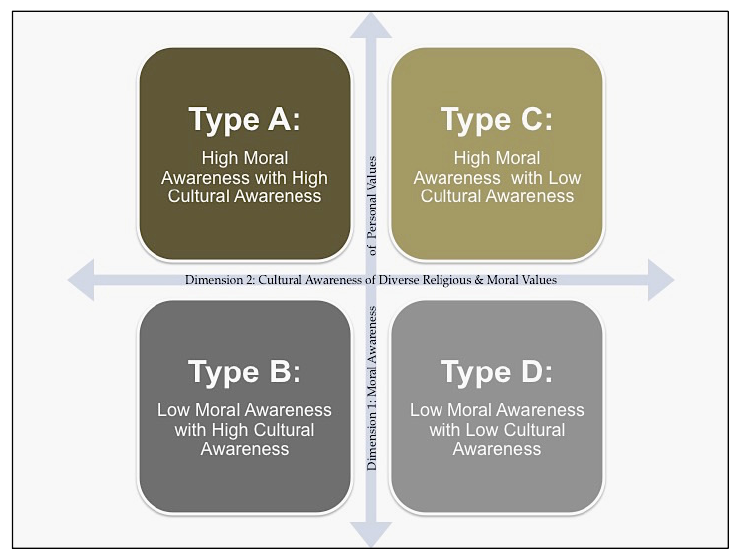
Figure 4. Two ‐ Dimensional Framework of Written Work In ‐ Depth Analysis. Dimension 1: Moral awareness ranging from high (top) to low (bottom) with Dimension 2: Cultural awareness ranging from high recognition of diverse religious and moral values (left) to low cultural awareness (right).